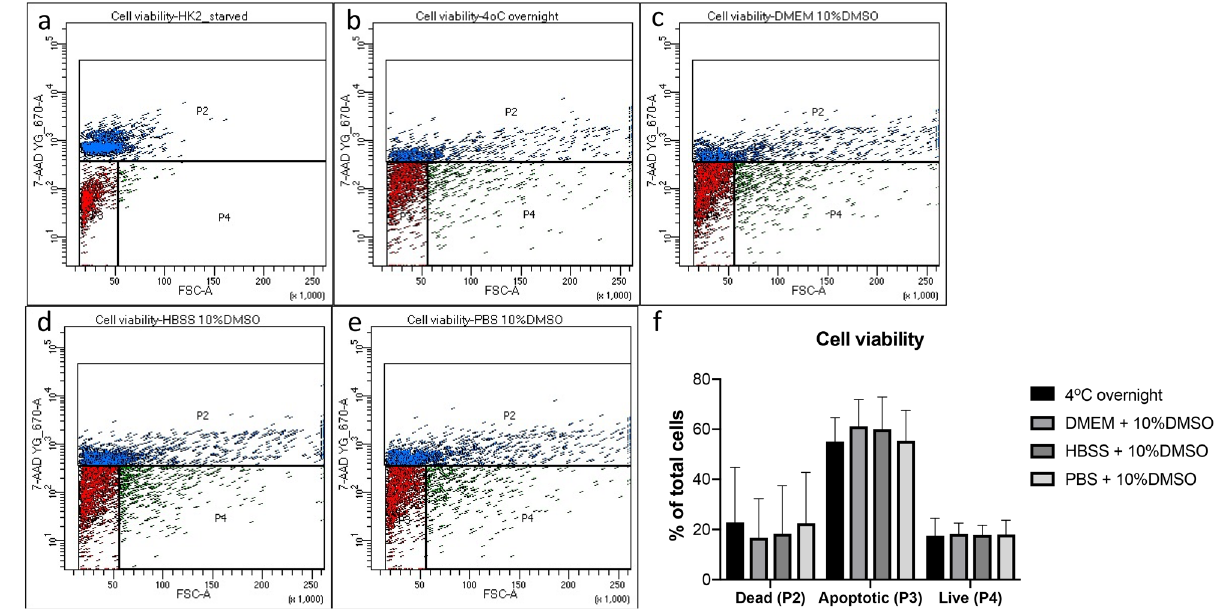
Figure 1. The effects of storage conditions on urinary cell viability. Cells are stored at different conditions and stained with 7-AAD. ( a ) Positive staining control: Starved HK2 cells; ( b ) Urinary cells kept at 4 °C overnight;